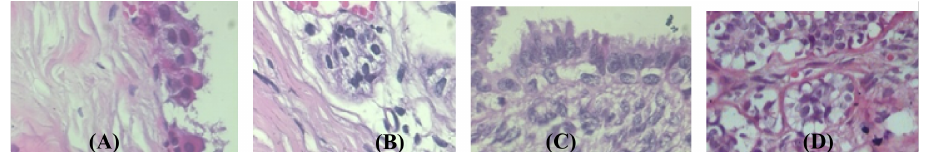
Figure 9. Sample of benign subtypes: ( A ) adenosis; ( B ) fibroadenoma; ( C ) phyllodes tumor; ( D ) tubu- lar